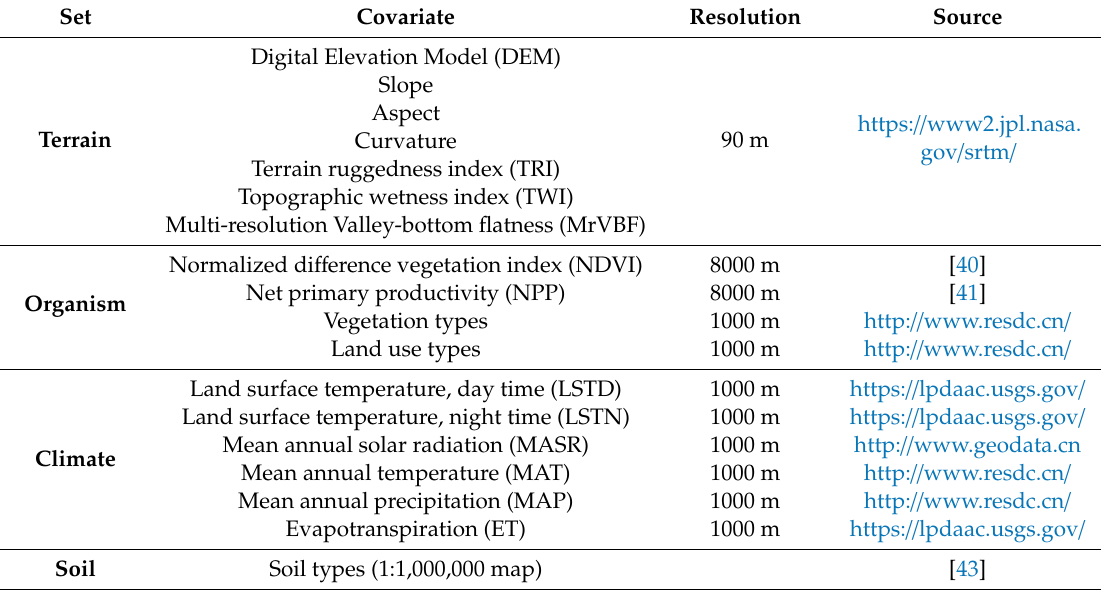
Table 1. Environmental covariates used in modeling soil